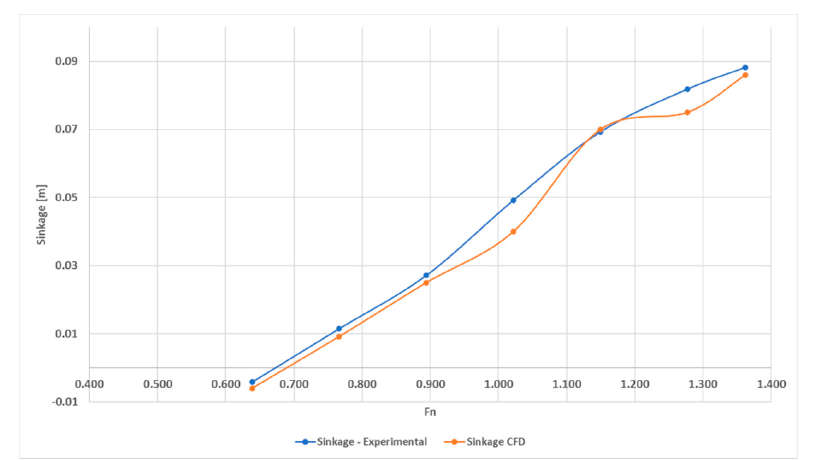
Figure 11. Trim comparison.